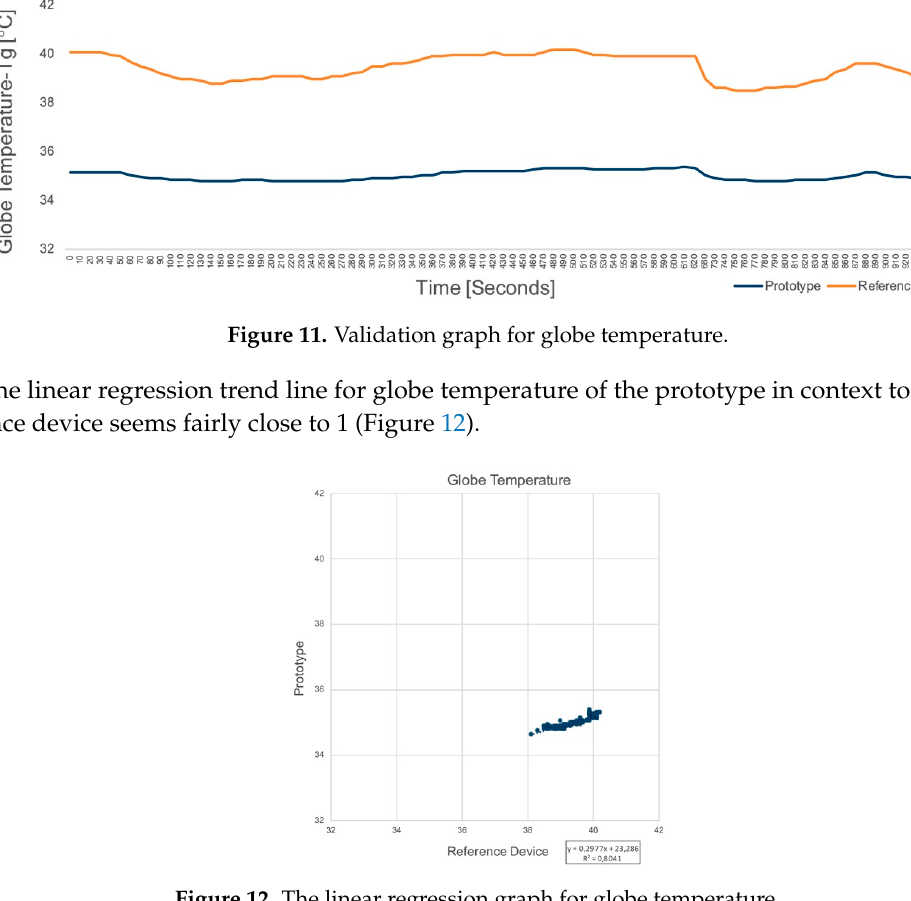
Figure 10. Validation setup with prototype and the test reference.